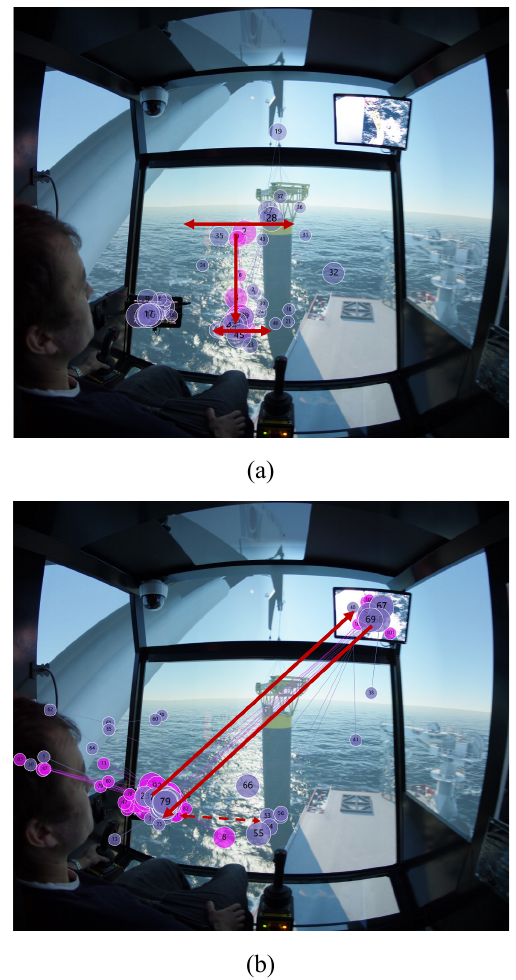
Figure 11: Extracted scanpath mode in (a) target stage one, and (b) target stage